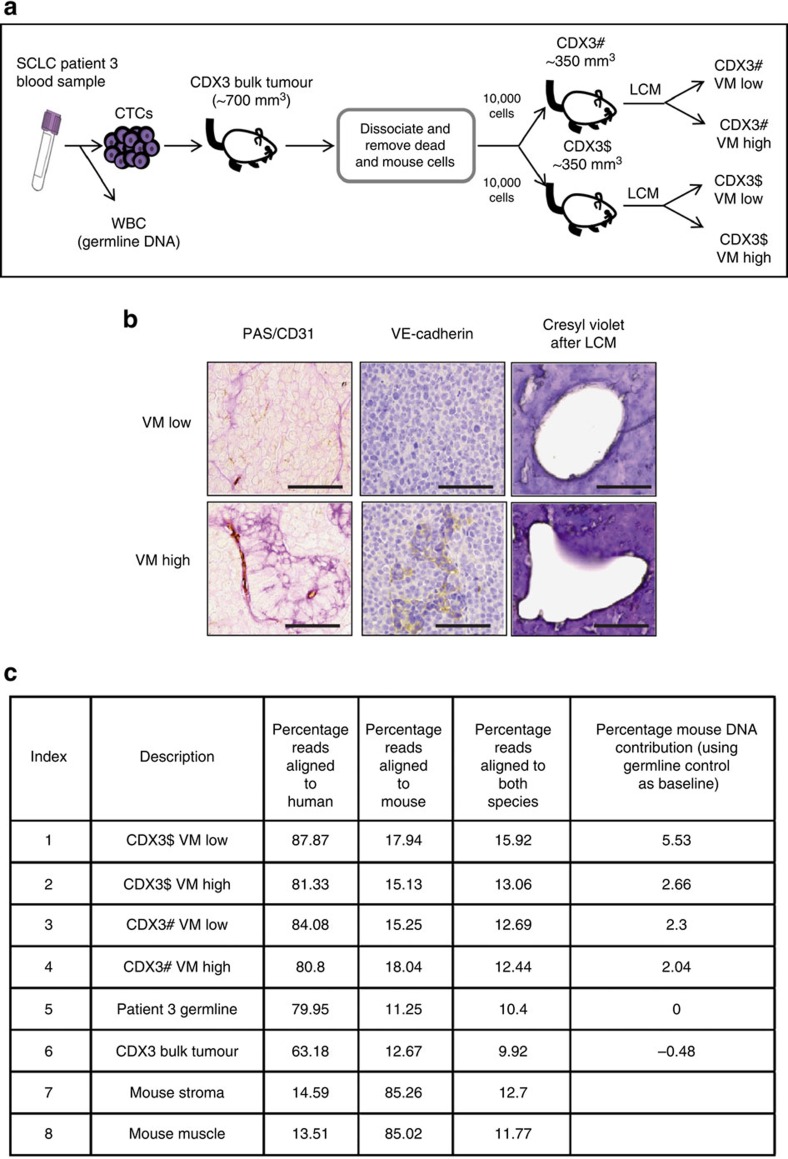
LCM and genomic analysis of VE-cadherin-positive VM vessels in CDX.(a) Schematic representation of generation of CDX3 and subsequent samples used for VM analysis, genomic analysis and targeted sequencing of LCM regions. White blood cells (WBC) used to generate germline control DNA. (b) IHC staining for PAS/CD31, VE-cadherin and (non DNA damaging) Cresyl Violet with VM-low/-high LCM area from CDX3 tumour. Scale bar, 100 μm. (c) Sequencing data from the 8 different samples used for genomic analysis demonstrating minimal mouse cell contamination and predominantly human genomes in VM structures in vivo. All reads were aligned to both human and mouse genome separately.